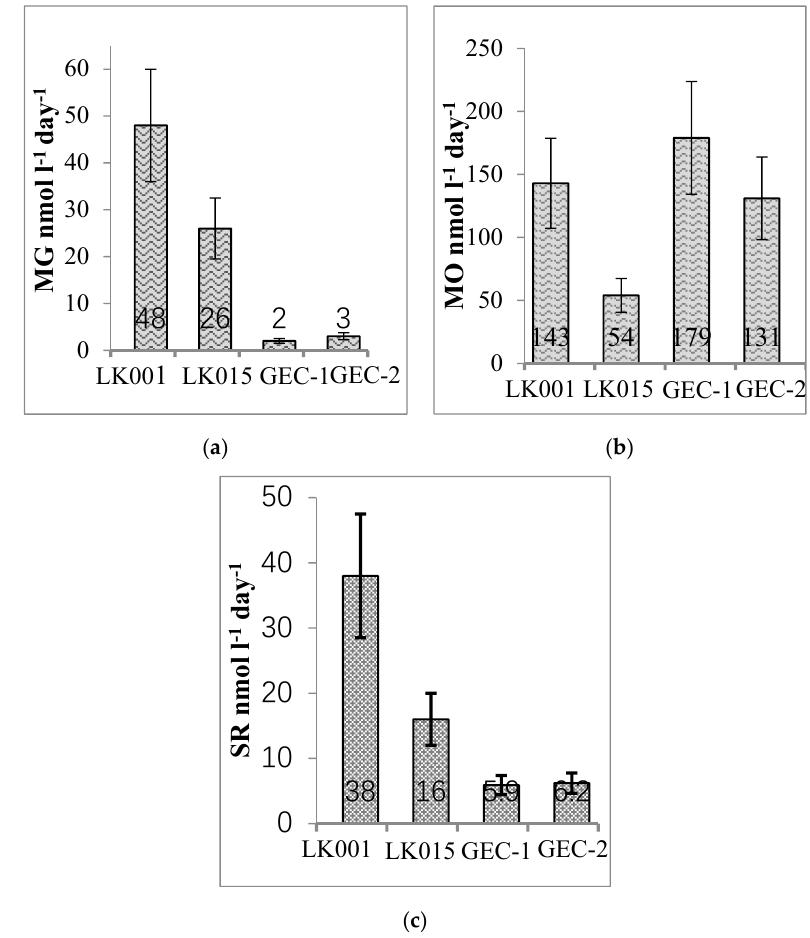
Figure 5. The average rates of the microbial processes of methane production (MG, ( a )), methane oxidation (MO, ( b )), and sulfate reduction (SR, ( c )) in the bottom sediments of the Yamal background lakes (LK001, LK015) and gas emission crater lakes (GEC-1, GEC-2) in April 2018.